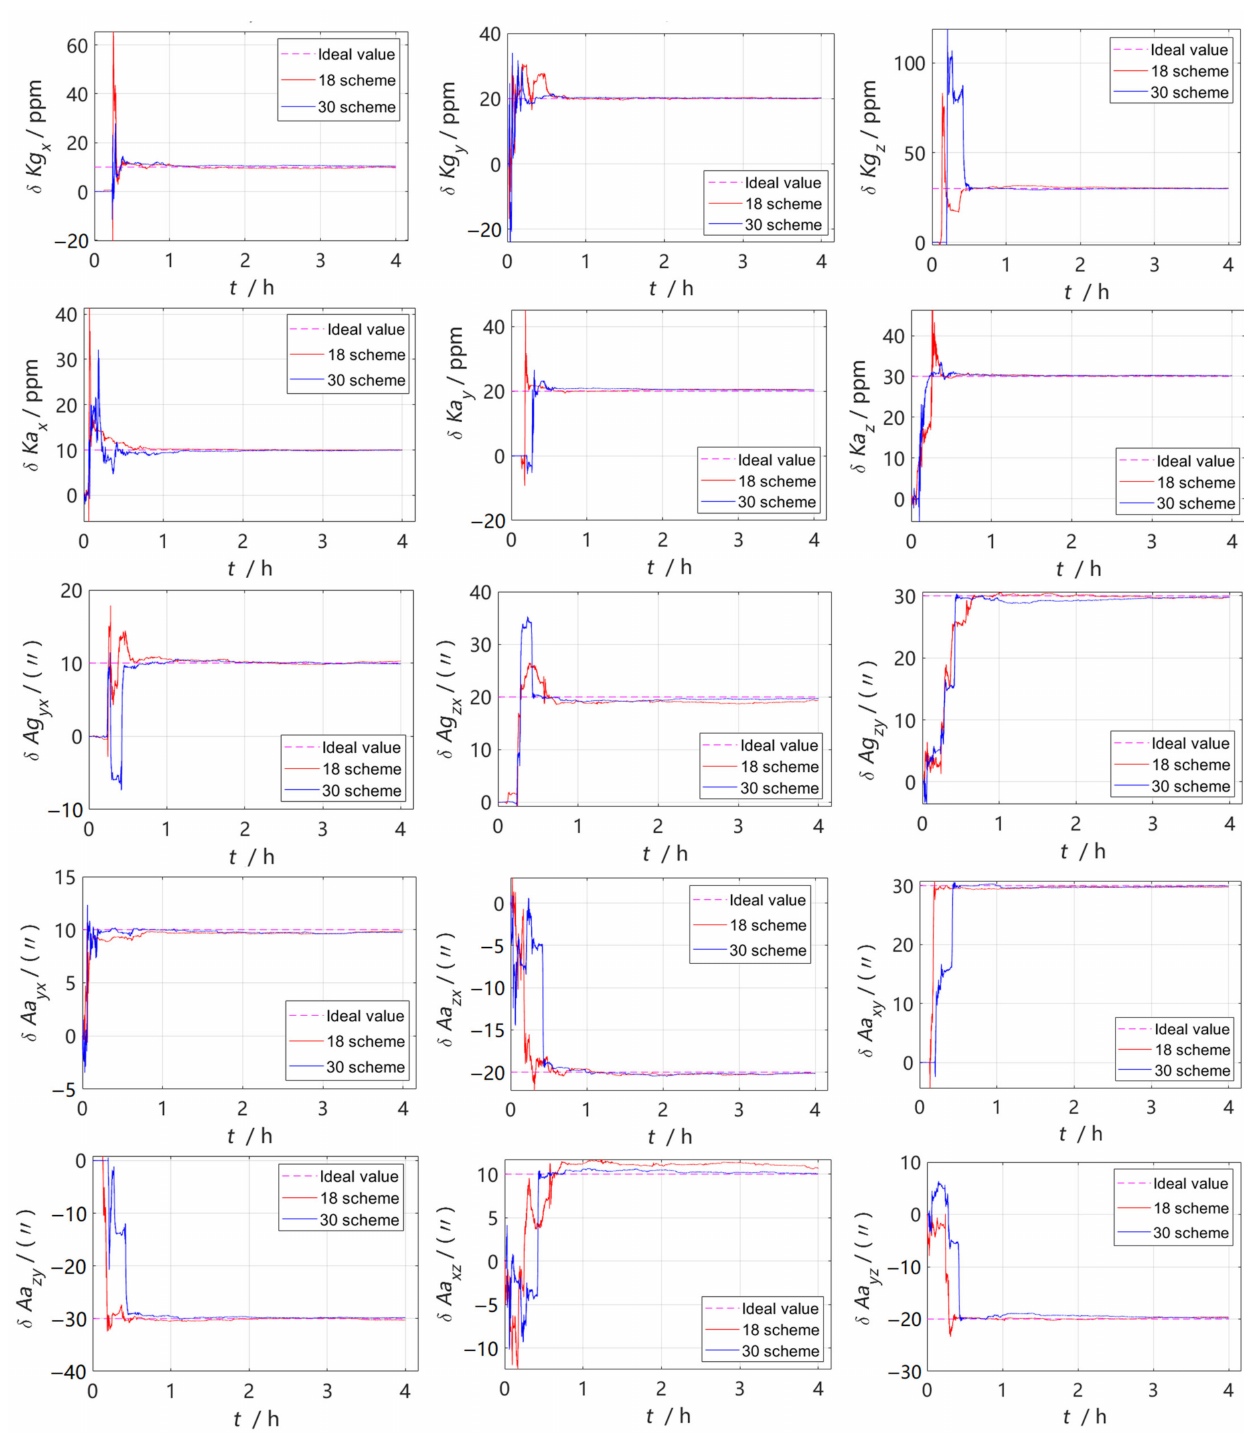
Figure 1. Error parameter estimation curve in